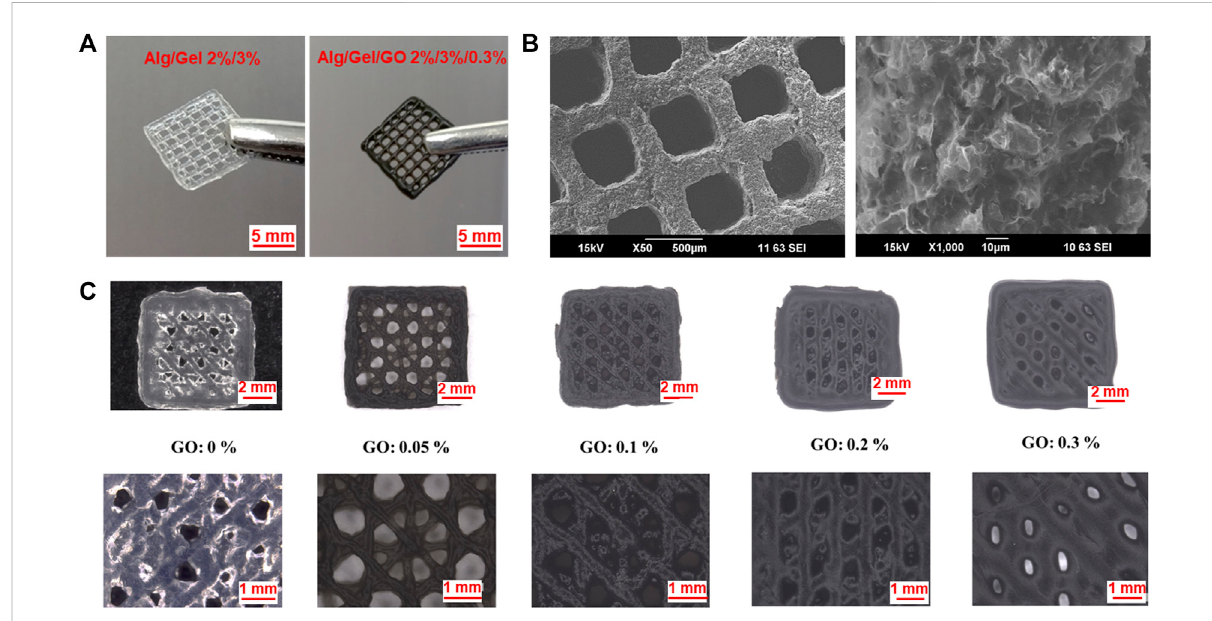
FIGURE 3 Morphology of 3D printed Alg/Gel/GO scaffolds. Photographs of structures obtained using the following bioink compositions (A) Alg/Gel (2%/ 3%, w/w) and Alg/Gel/GO (2%/3%/0.3%, w/w). (B) SEM images of 3D printed structures obtained using 2%/3%/0.3% (w/w) Alg/Gel/GO at different magni fi cations. (C) Optical images of 3D printed scaffolds with different GO ratios printed under the same conditions.